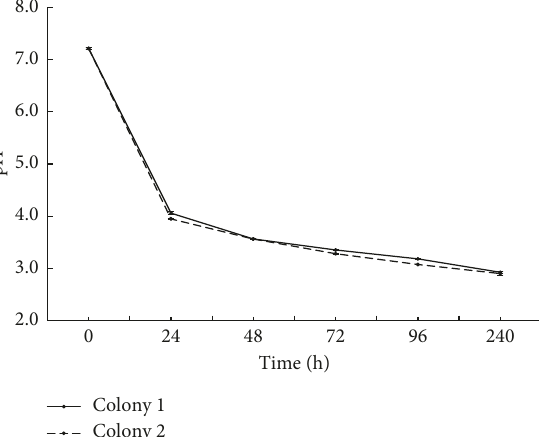
Figure 2: pH trend for Colonies 1 and 2 in mineral commercial water. Conditions: 5% sucrose, initial pH solution ratio. The results are expressed as the mean of three